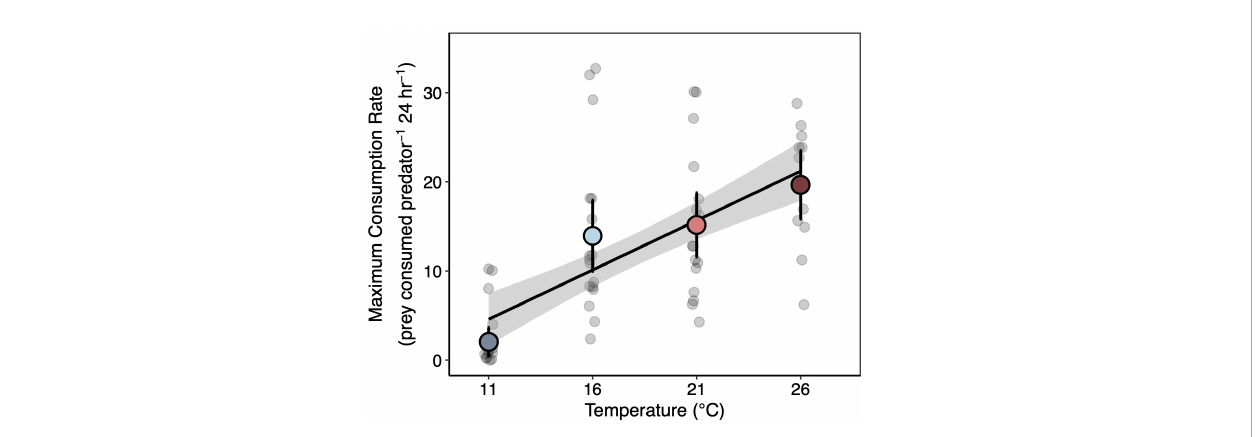
FIGURE 3 Temperature Effects on Lobster Functional Responses. Type II functional responses fi t using a Bayesian hierarchical framework. Gray curves represent individual lobsters and colored curves represent treatment means (left to right: light blue = 11°C, dark blue = 16°C, light red = 21°C, dark red = 26°C). Solid gray regions highlight the 95% credible intervals estimated at the treatment